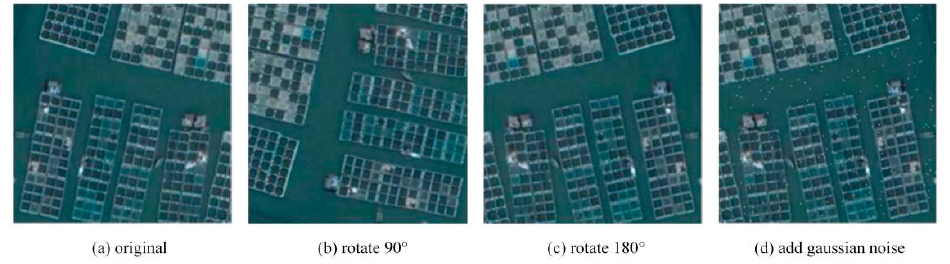
Figure 2. ( a ) The original image; ( b ) the image is obtained by rotating 90 ◦ counterclockwise; ( c ) the image is obtained by rotating 180 ◦ counterclockwise; ( d ) the image has added Gaussian noise and is rotated 180 ◦ .